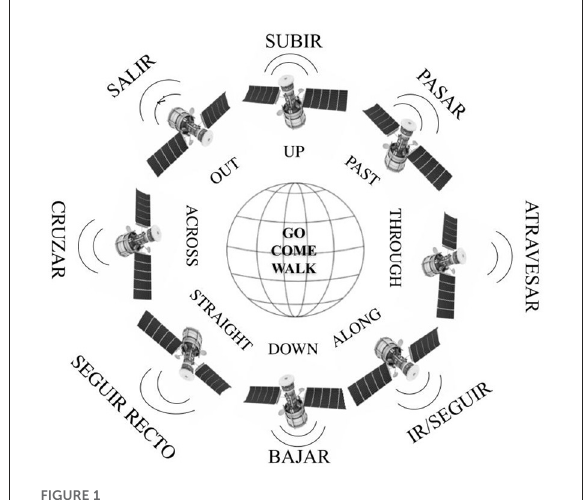
FIGURE1 Didactic model presented by the